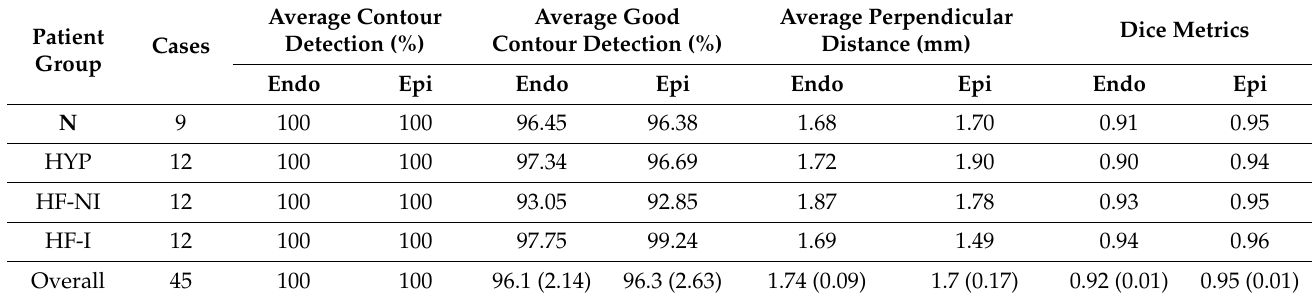
Table 9. Performance evaluation parameters for focal Tversky loss and Elu activation.